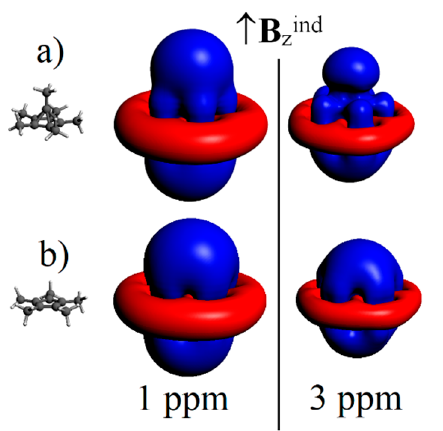
Figure 4. B zind terms of the induced magnetic field for C 6 (CH 3 ) 6 2+ ( a ) and C 5 (CH 3 ) 5 − ( b ), at 1 and 3 ppm. Blue: shielding; red: deshielding.